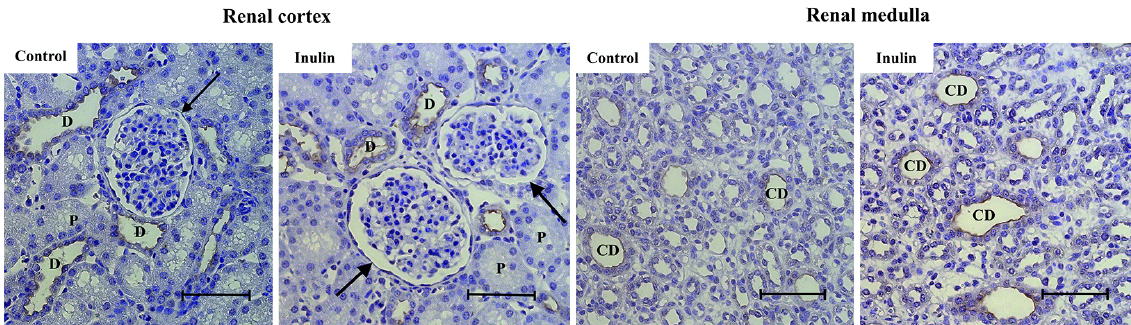
Figure 2. Immunolocalization and immunoexpression of TRPM7 in the renal cortex and medulla of the control group and pigs fed a diet supplemented with 2% inulin. The letters and markers on microphotography indicate the following: D – distal tubules; P – proximal tubules; black arrow – glomerulus; CD – collecting ducts. Bar = 50µm.